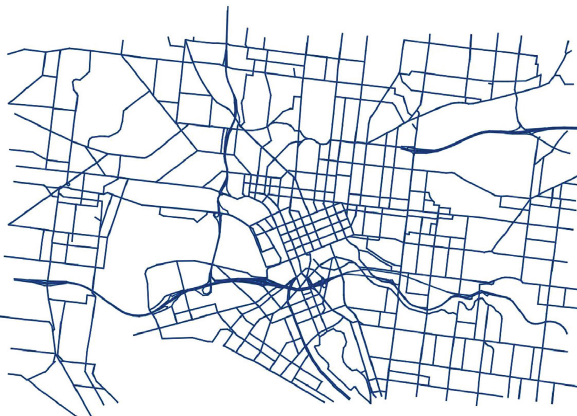
Figure 1: Subnetwork of Melbourne metropolitan